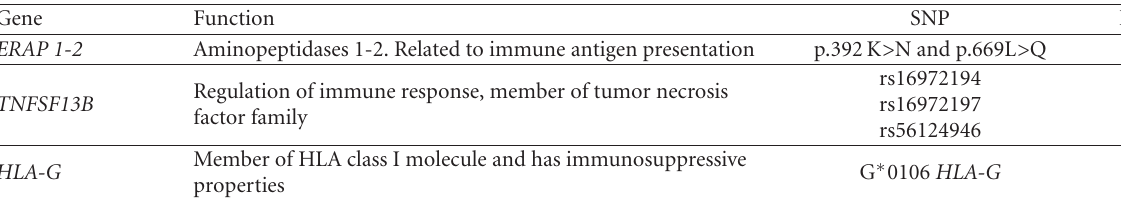
Table 1: Overview of the di ff erent polymorphism